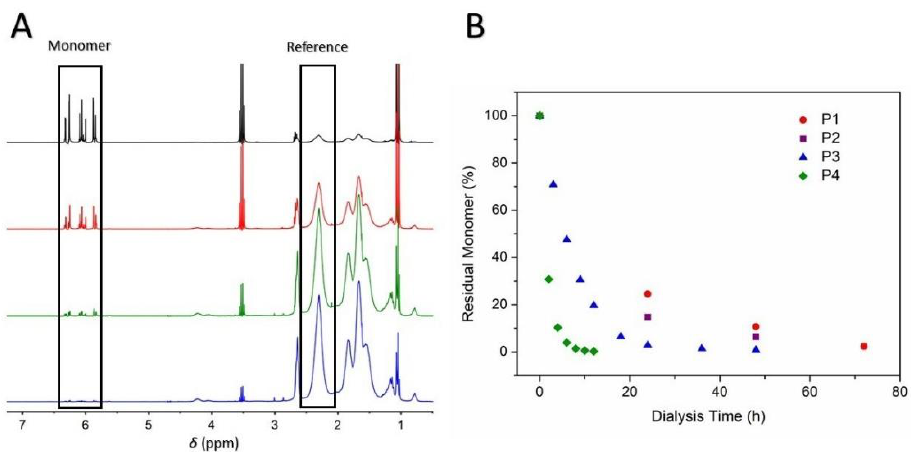
Figure 3. ( A ) 1 H NMR spectra in D 2 O with a water suppression function for polymer P4 at different times to monitor the dialysis process. ( B ) Residual monomer vs. dialysis time for aqueous solutions of polymers P1 – P4.